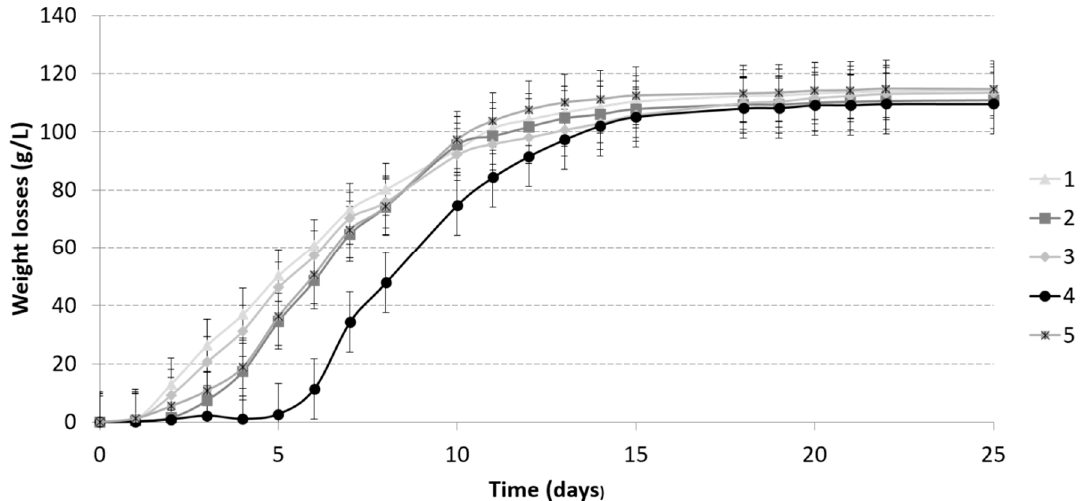
Figure 2. Alcoholic fermentation curve of S. cerevisiae Level 2 ® (1), and sequential fermentations with S. cerevisiae Level 2 ® and T. delbrueckii Level 2 ® (2), M. pulcherrima Flavia ® (3), P. kluyveri FrootZen ™ (4), and L. thermotolerans Concerto ™ (5).